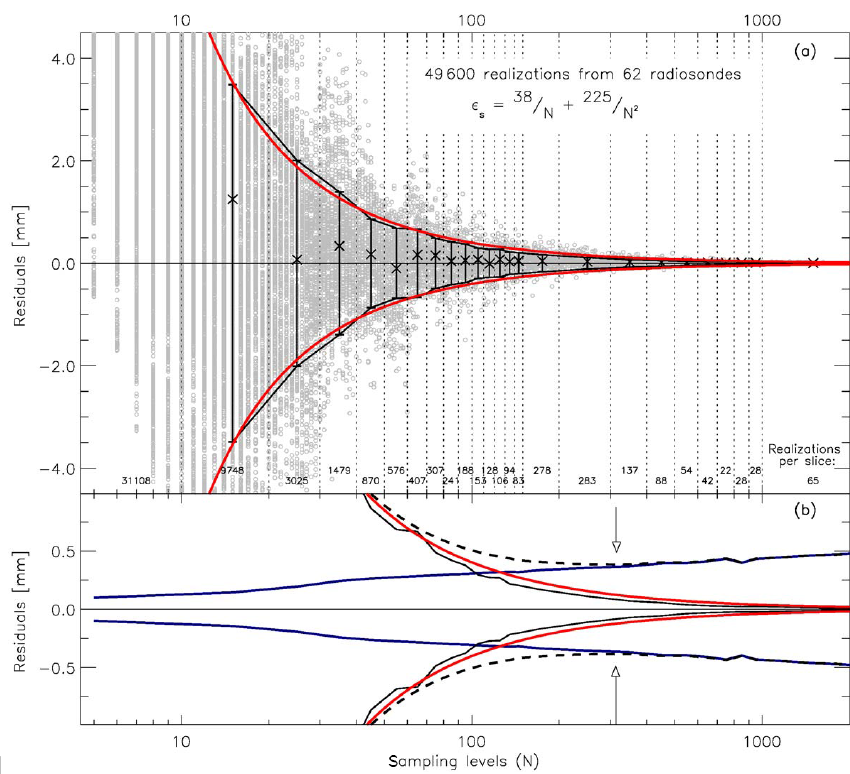
Figure 2. (a) Example of sampling error modelling for PWV radiosondes, as a function of the number of levels (see Fig. 4 to see the model fitting for all the sites). The profiles are gradually sub-sampled to obtain a large number of realizations of PWV (grey circles). The error is then fitted (red solid lines; see Eq. 18) to the RMSE of the residuals (see Eq. 16) in sliced (dotted lines) sampling levels. The error bars show the RMSE per slice and the “x” symbols are the bias. (b) Sub-sampling error optimization. The solid black line is the experimental sample error as a function of the number of levels and the red line is the model (same as in panel a but with trimmed y axis). The blue line is the median of the propagated uncertainties (Eq. 8) for all the profiles and the dashed line is the final error (Eq. 7). The arrows show the optimized number of samples for the minimum